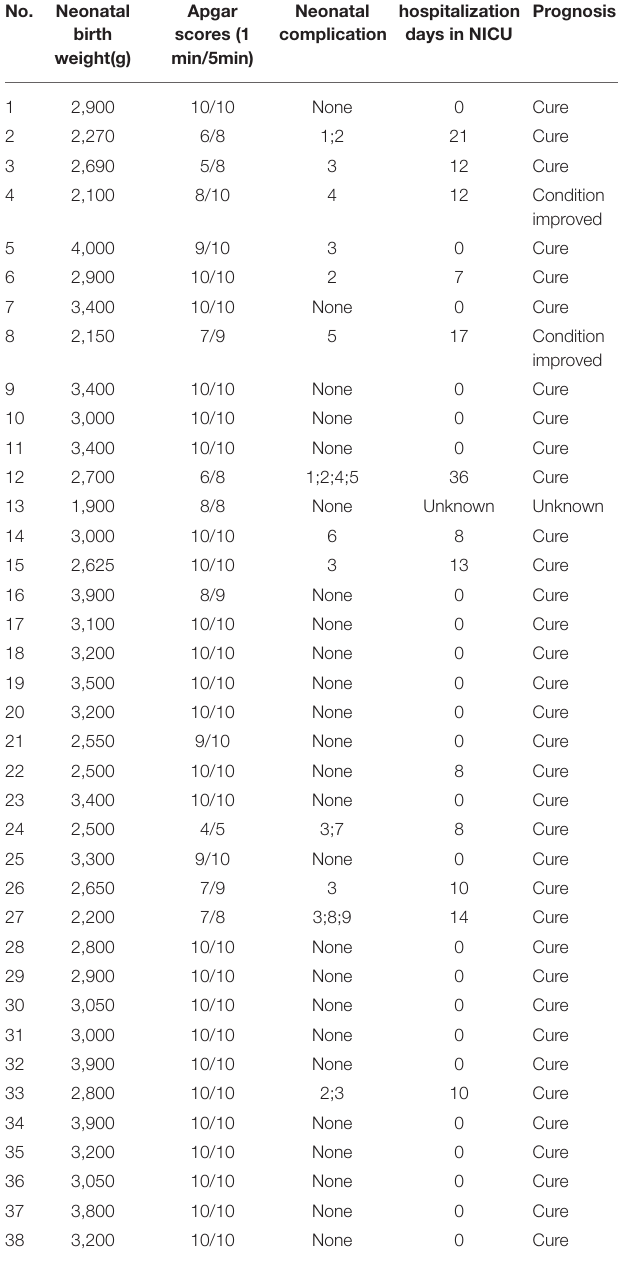
TABLE 3 | Neonatal characteristics of study